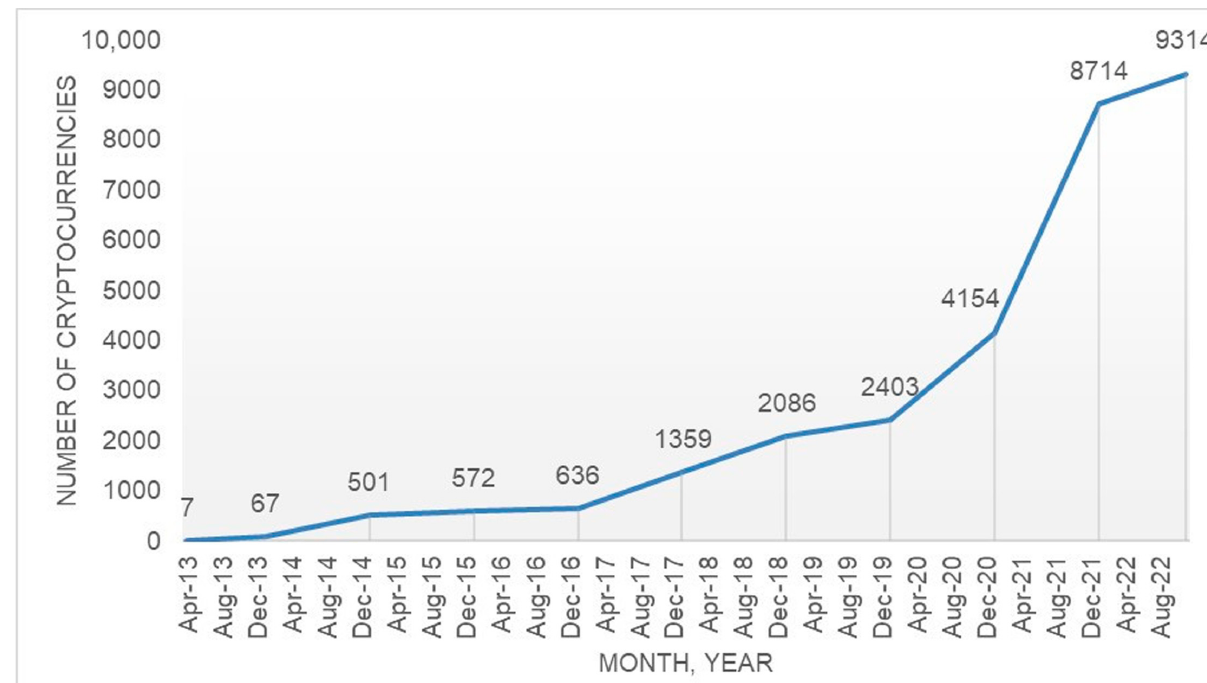
Figure 1. Cryptocurrency expansion in the last decade.